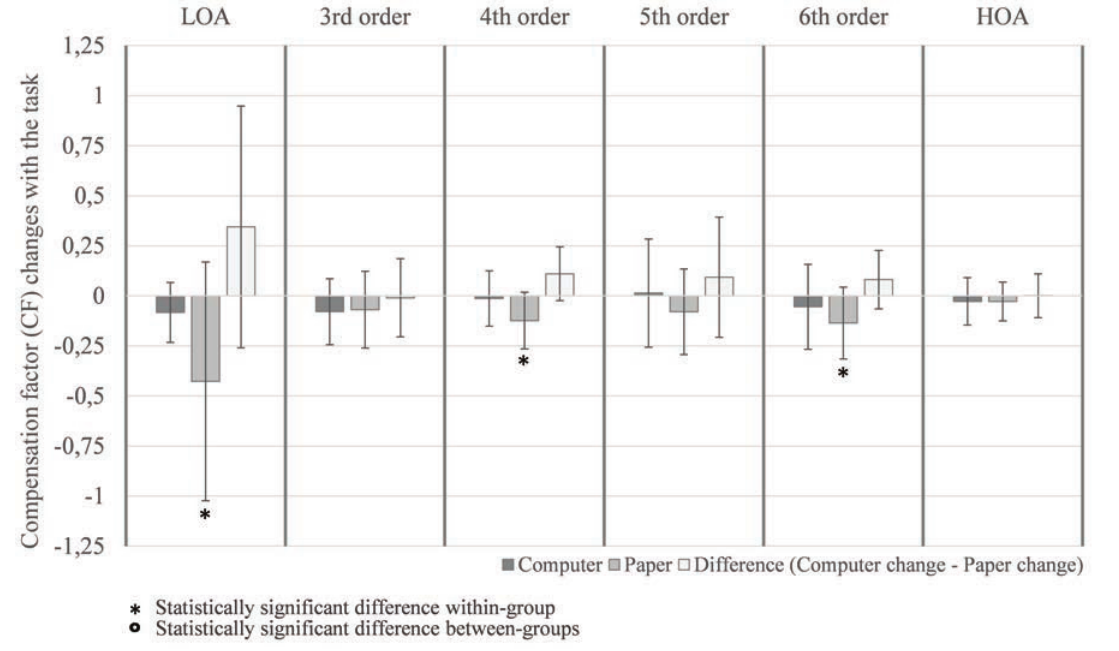
Figure 2. Compensation factor mean changes of LOA, HOA, and third, fourth, fifth, and sixth-order aberrations with the reading task in the computer and paper groups and the differences between their changes, with 95%- confidence-interval error bars. CF decreased with the task, and statistically significant changes were found in the paper group. There were no statistically significant differences between the changes found in the paper and computer groups with the task.